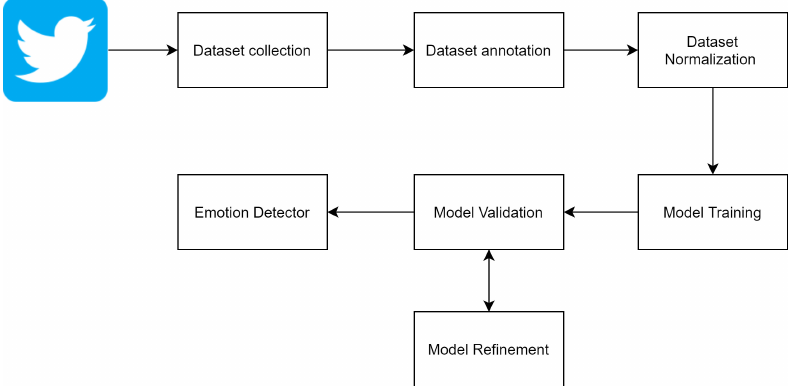
Figure 5. Dataset usage in model